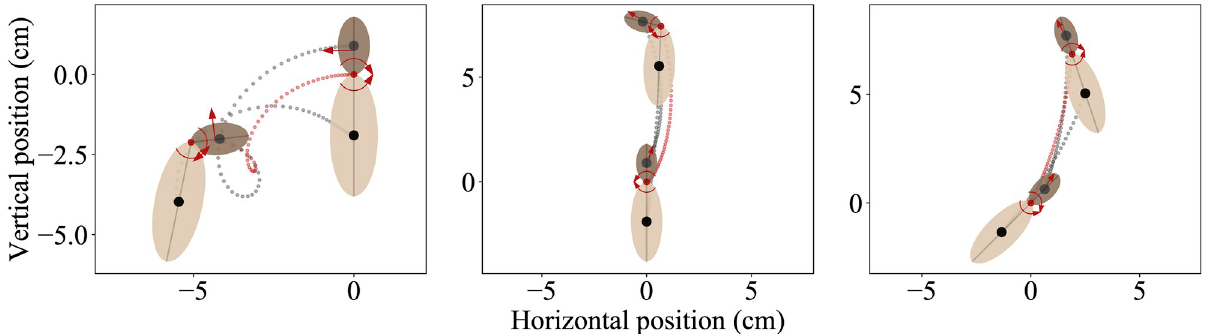
Fig 6. Example trajectories of the simulated insects. Each trajectory is 20 ms, and each starts at (x,y) = (0,0). Force ( F ) is indicated with the straight red arrow, and torque ( τ ) is shown with the curved arrows at the thorax-abdomen joint (red dot). The center of mass of each body segment is shown with black